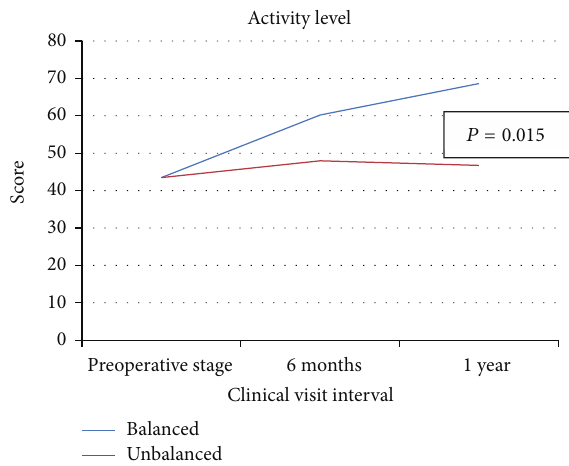
Figure 5: The lines indicate the change in patient activity levels for the balanced and unbalanced cohorts from preoperative stage to 1